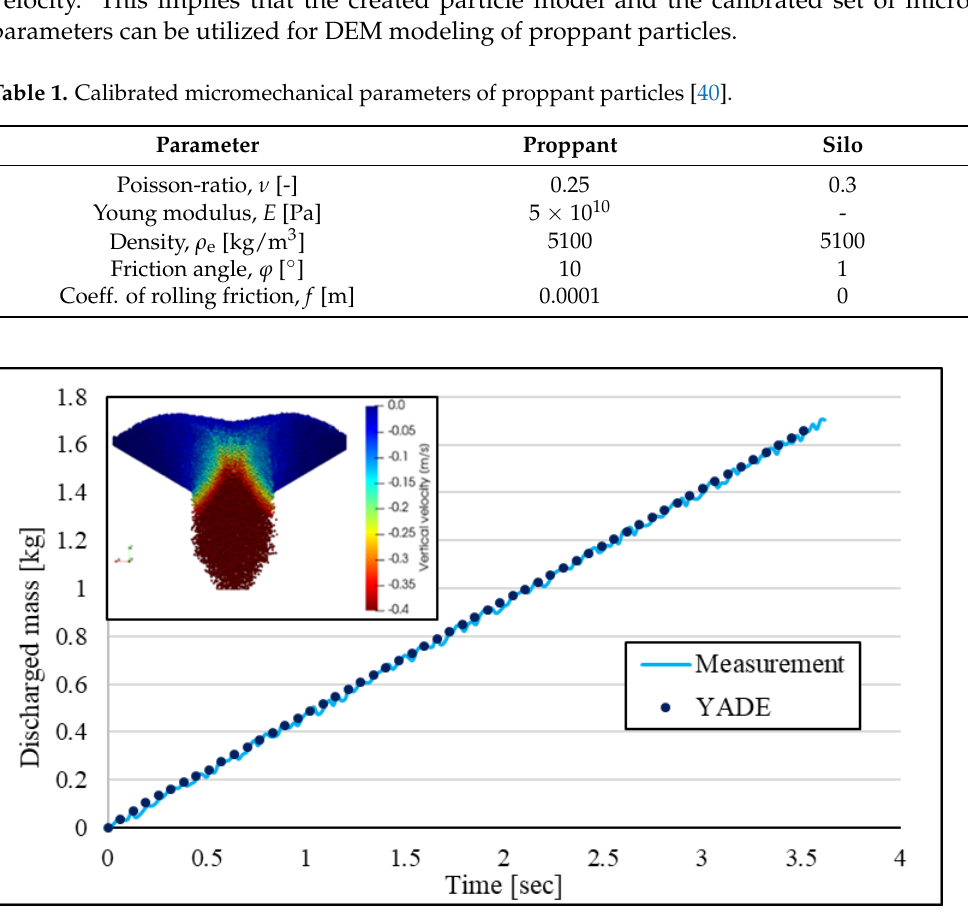
Figure 6. Comparison of measured and calculated mass – time functions [44]. Table 1. Calibrated micromechanical parameters of proppant particles